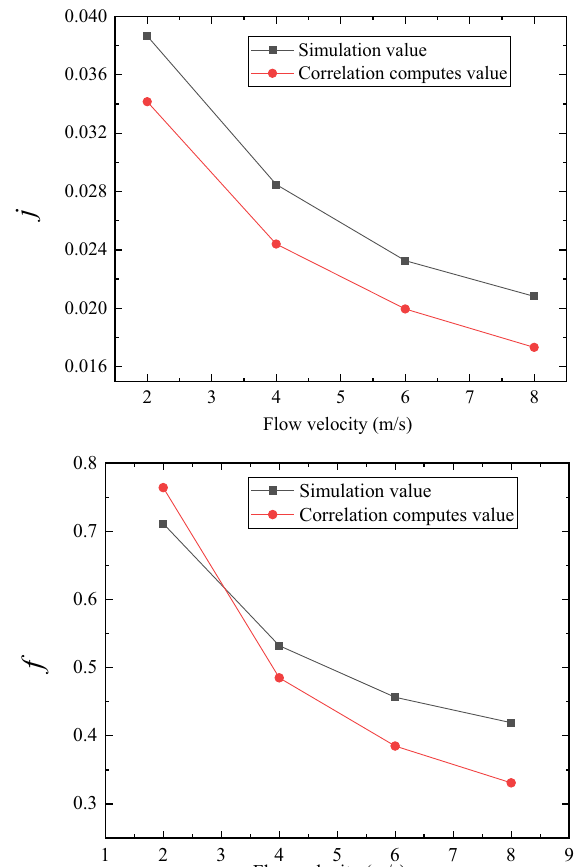
Figure 3 Comparison of simulation results and empirical correlation calculation